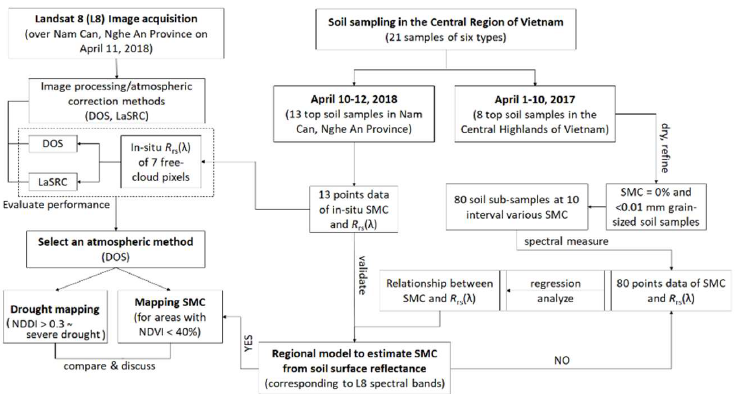
Figure 2. Flowchart of the methodology to estimate and map the soil moisture content (SMC) over the Central Region of Vietnam, using Landsat 8 (L8) images.